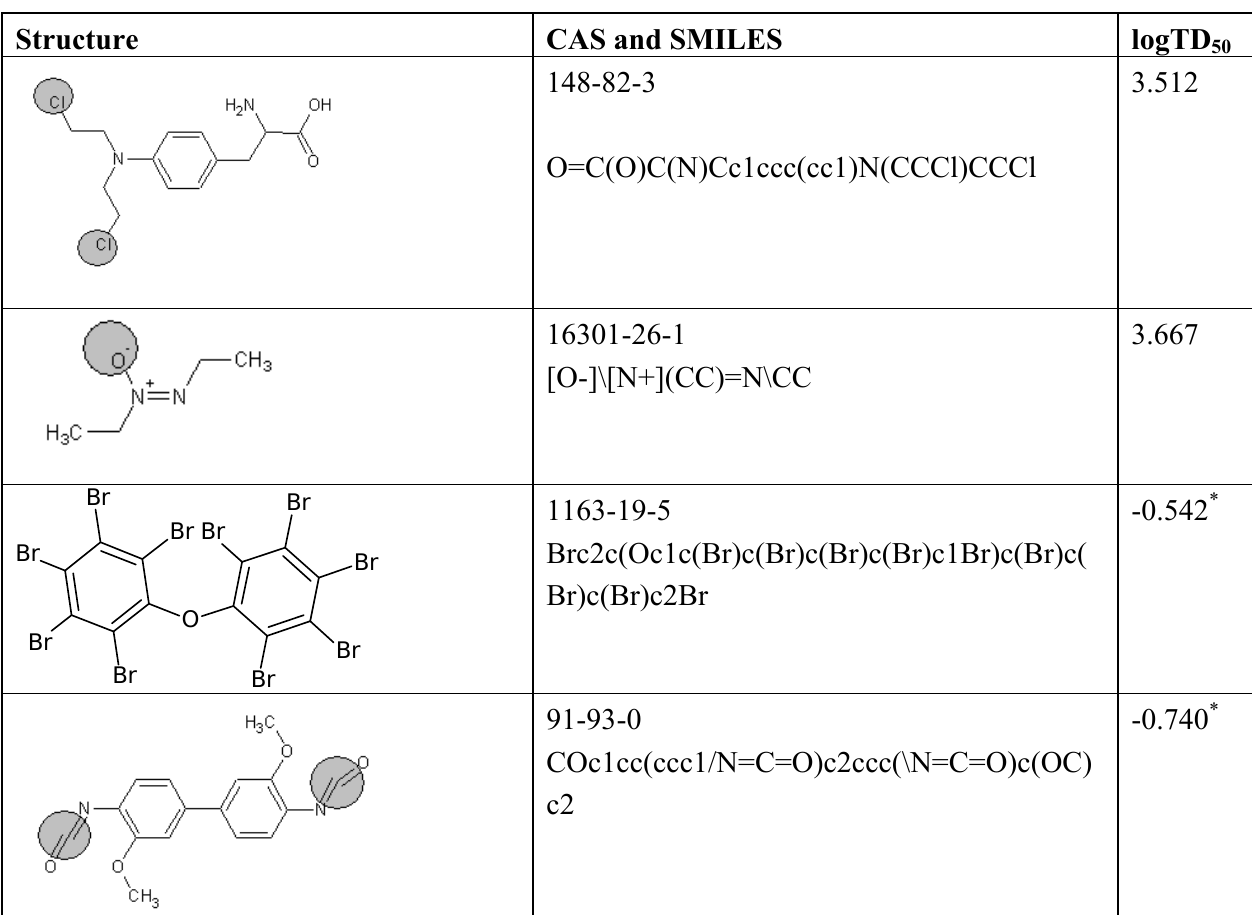
Table 6. Examples of compounds which contain promoters of increase/decrease of the logTD